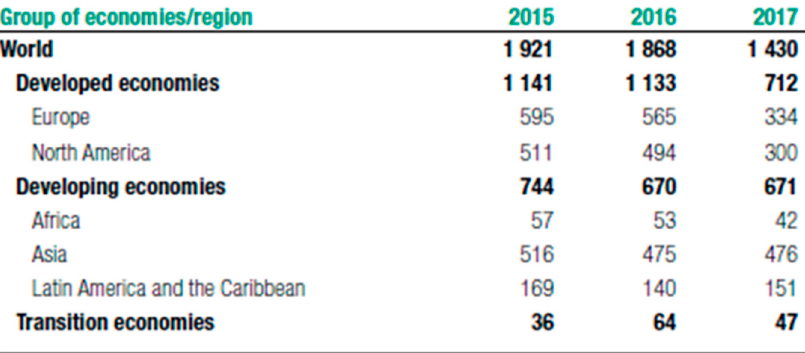
Figure 2. FDI inflows 2015–2017 to regions and economies (USD $billion). Source: UNCTAD (FDI/MNE database: www.unctad.org/fdistatistics).